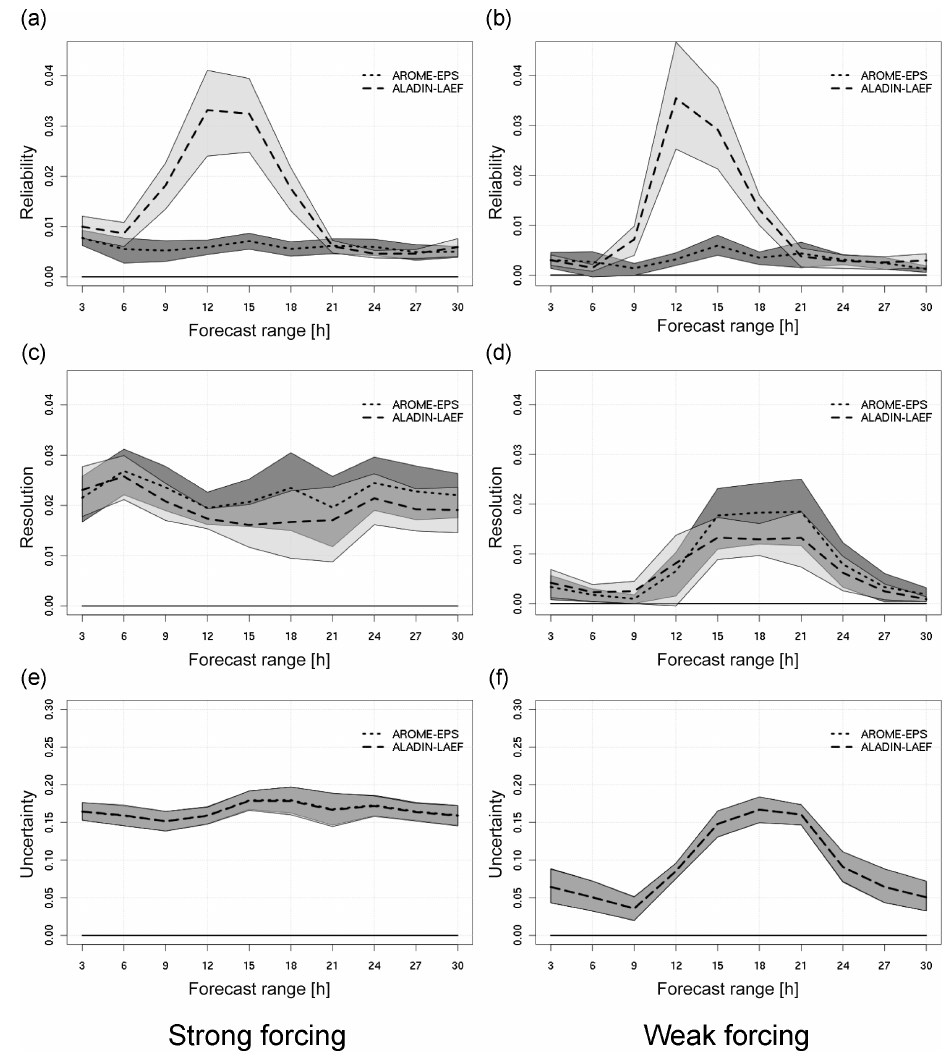
Figure 6. Time evolution of the Brier score components, reliability (top), resolution (center), and uncertainty (bottom), with confidence intervals (shades) for region Austria, AROME-EPS (dotted line), and ALADIN-LAEF (dashed line). The results are shown for a precipitation threshold of 0.1mm/3h. Left panels depict results for days with strong synoptic forcing, right panels results for days with weak synoptic